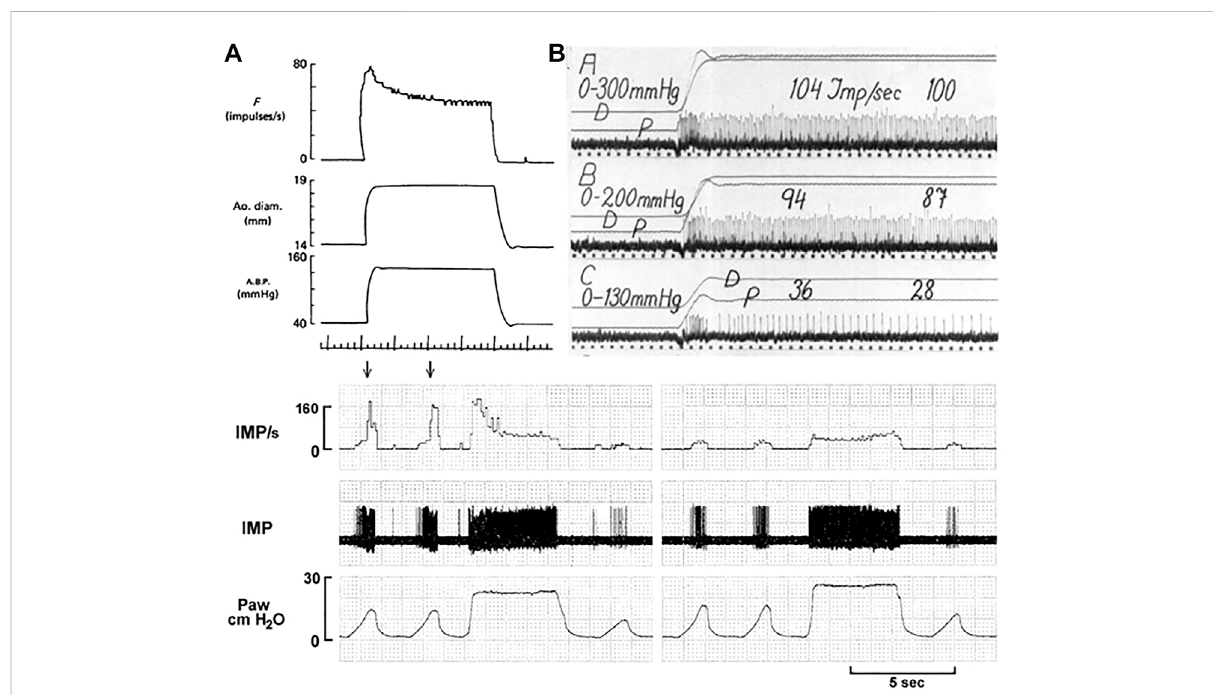
FIGURE 10 Unit adaptation in both processed data (left) and original recording (right). Left: A dog aortic BR unit in response to a step increase in constant aortic pressure. Traces: baroreceptor impulse frequency (F), aortic diameter, aortic pressure and time trace (1 s). [Figure 8 (Coleridge et al., 1984)]. Right: A cat carotid sinus BR unit in response to different distending pressure steps from 0 to 130, 200 and 300 mmHg. p , Intrasinus blood pressure; D, Diameter of the sinus. The time marks are 1/25 s [Figure 9 (Landgren, 1952a)]. Bottom. This airway unit contains RAR (high threshold and frequency)andSAR(lowthresholdandfrequency)sharinganafferentaxon.In (A) ,duringlungin fl ationtheunitstartswithSARactivation,producinga low discharge frequency; as the airway pressure increases, the RAR activates (denoted by two arrows), and discharges with very high frequency. During constant lung in fl ation the unit initially discharges with a higher RAR frequency, but rapidly adapts to a SAR steady state. In (B) , two receptive fi elds are identi fi ed connected to the afferent. Blocking one fi eld with 2% lidocaine, the rapidly adapting component disappeared and left only the slowly adapting component, which exhibited continuous lower discharge frequency. IMP, impulses; Paw, airway pressure. [Figure 6 (Liu and Yu,